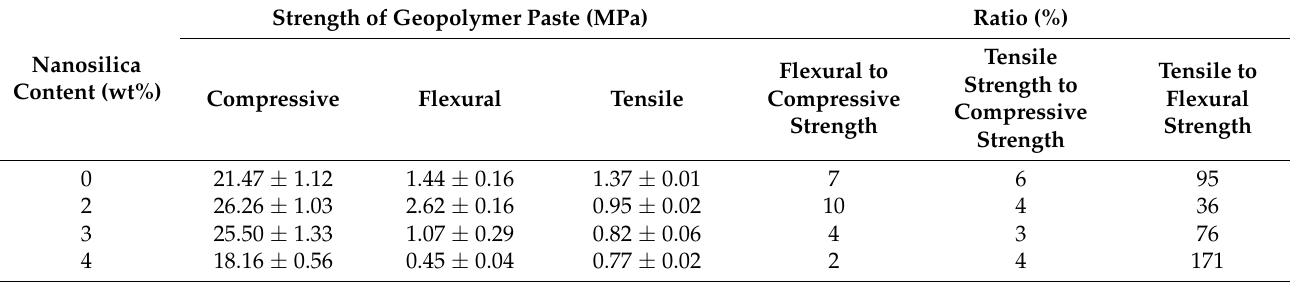
Table 4. The relation between compressive, flexural, and tensile strength of geopolymer paste.